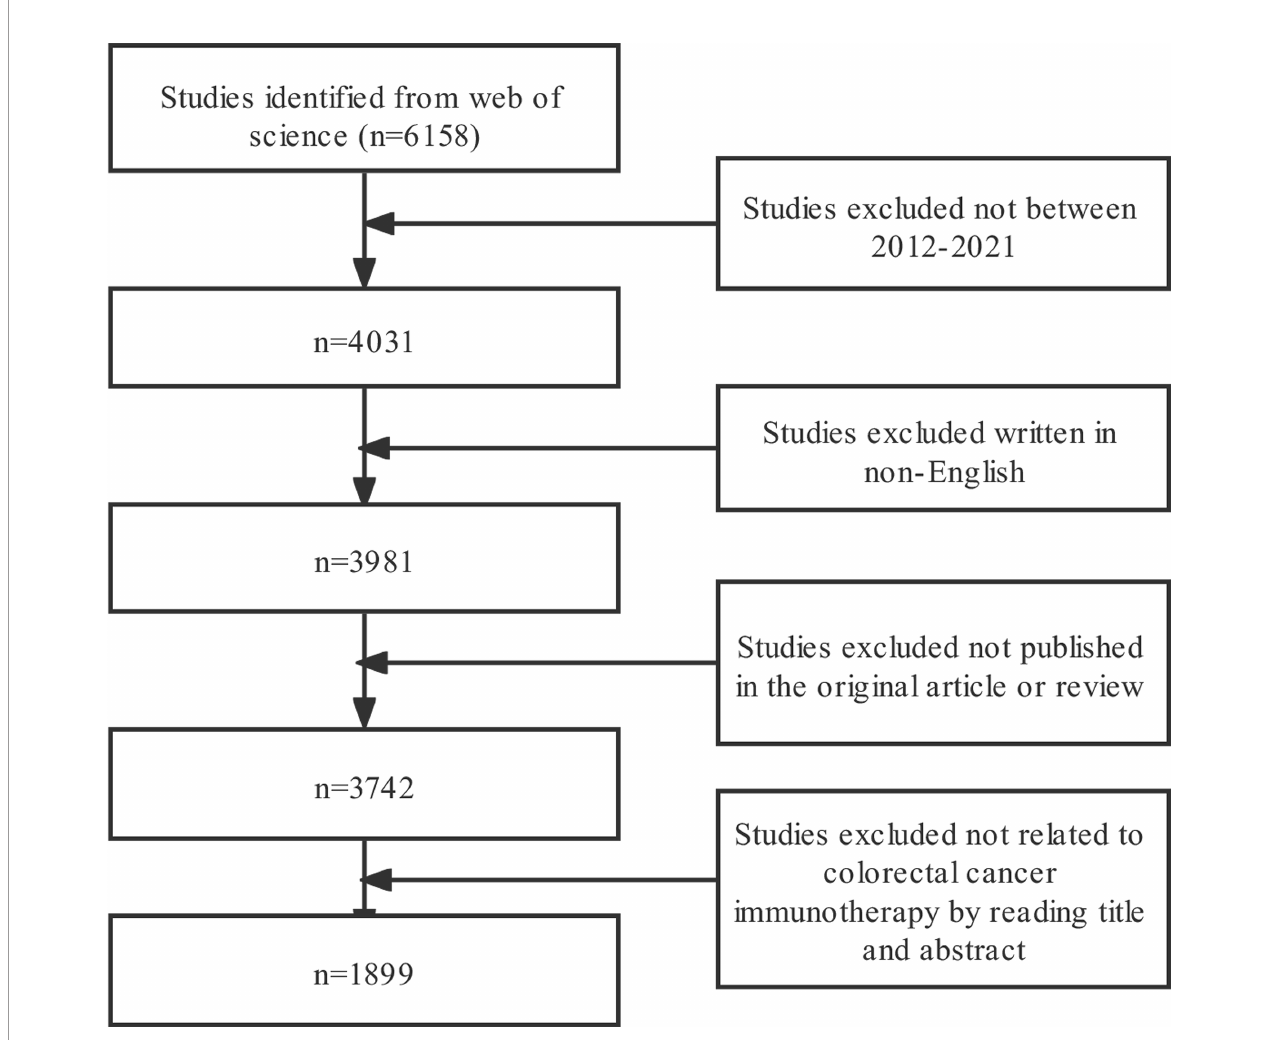
FIGURE 1 | Flowchart depicting the article selection